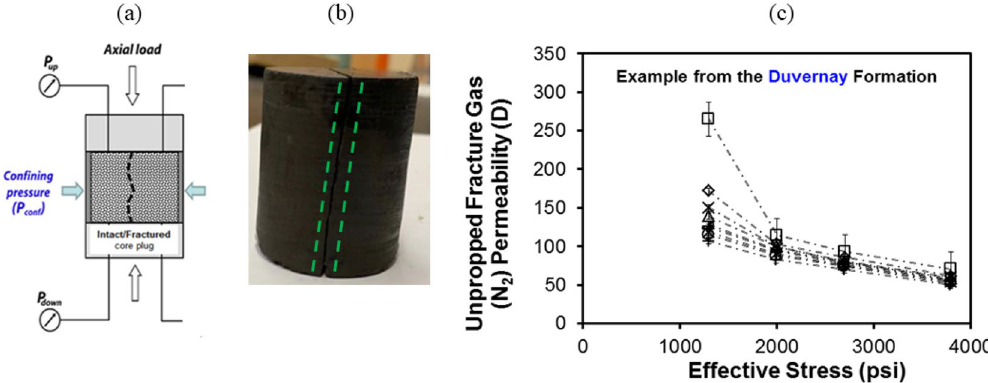
Figure 1. Use of biaxial coreholder to induce fractures in core plugs under stress and measure gas fracture permeability (a) ; example of core plug sample (Duvernay Formation, western Canada) fractured under differential stress in biaxial coreholder (b) ; example of unpropped fracture permeability measurements (c) . Modified after Ghanizadeh et al. 23 and Zhang et al. 24